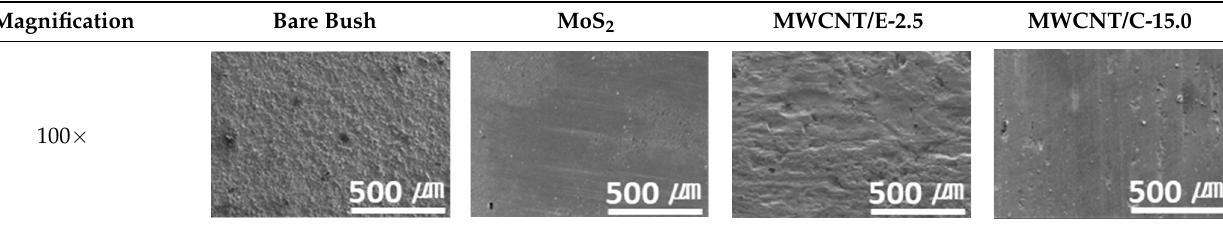
Table 5. Comparison of surface shapes after bush wear according to the addition of MoS 2 and MWCNT. Magnification Bare Bush